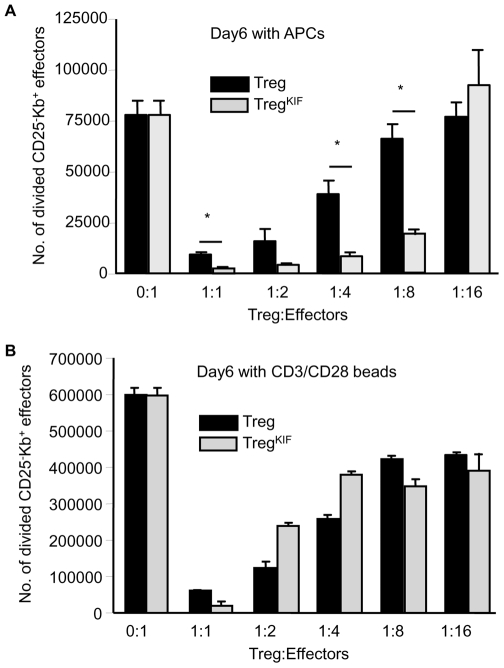
TregKIF retain their suppressive function in an in vitro MLR.Treg were purified from CBA mice and incubated for 30 mins with either PBS or KIF. Treg were cultured with CD3/CD28 beads with rhIL-2 for 24 hours and cultured at decreasing ratios with 1×105 CFSE-labelled CD25−CD4+ effector Kb+ T cells along with (a) 3×105 irradiated B10.B10S.F1 splenocytes or (b) 1×105 CD3/CD28 beads. After 6 days the cultures were harvested and numbers of divided CD25−CD4+ effector Kb+ T cells were calculated by FACS. Error bars represent the standard deviation. Experiments were carried out in triplicate and data are representative of 3 separate experiments. * p<0.05.